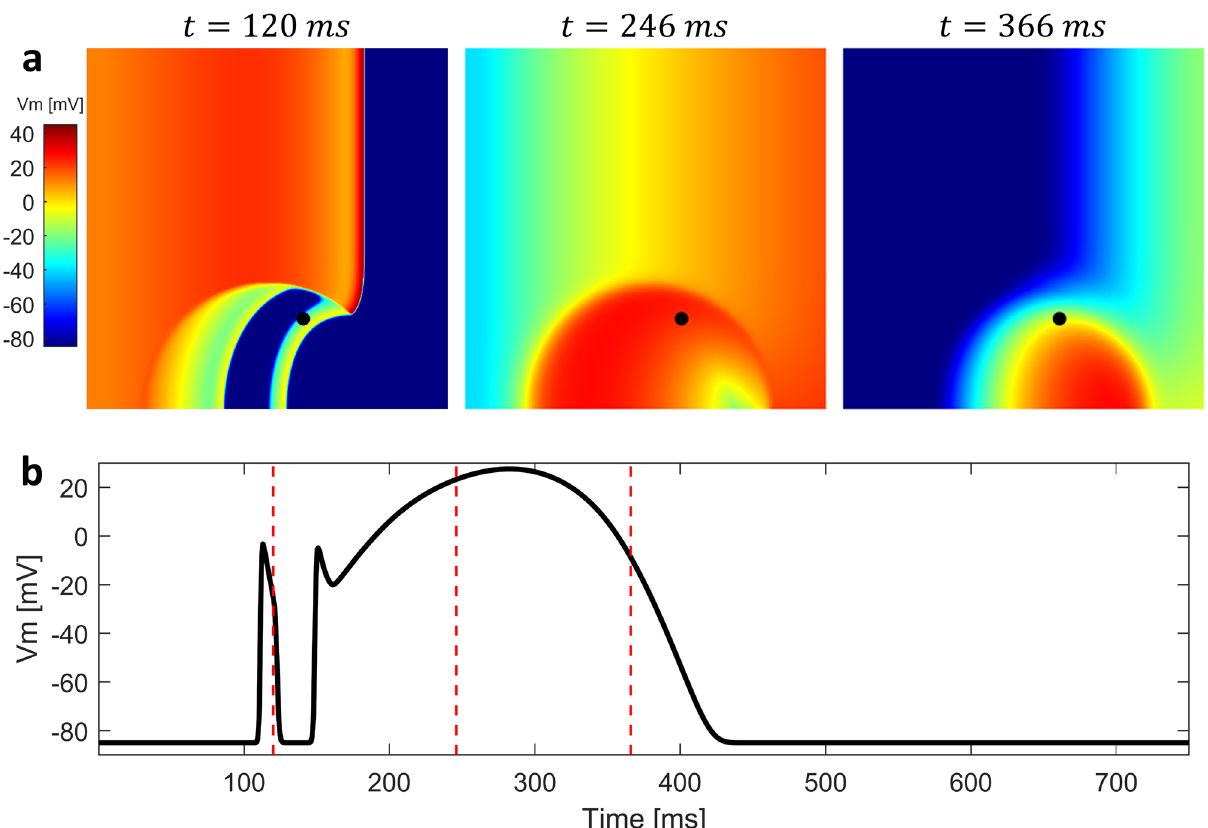
Figure 4. 2D simulation with altered electrophysiology in the BrS region without structural abnormalities. ( a ) 0 Sequence of snapshots taken from the 10 × 10 cm tissue model. The value of d w was 0.4, whereas the radius of the BrS region was 3.5 cm. Diffuse fibrosis was not present. Sustained reentry was not induced. ( b ) Membrane potential in the BrS region recorded in the point indicated by a black dot in the snapshots. After the first lost dome AP, orthodromic reentry generates a delayed dome AP caused by electrotonic currents from the healthy tissue. Red dashed lines indicate the time instants at which snapshots were